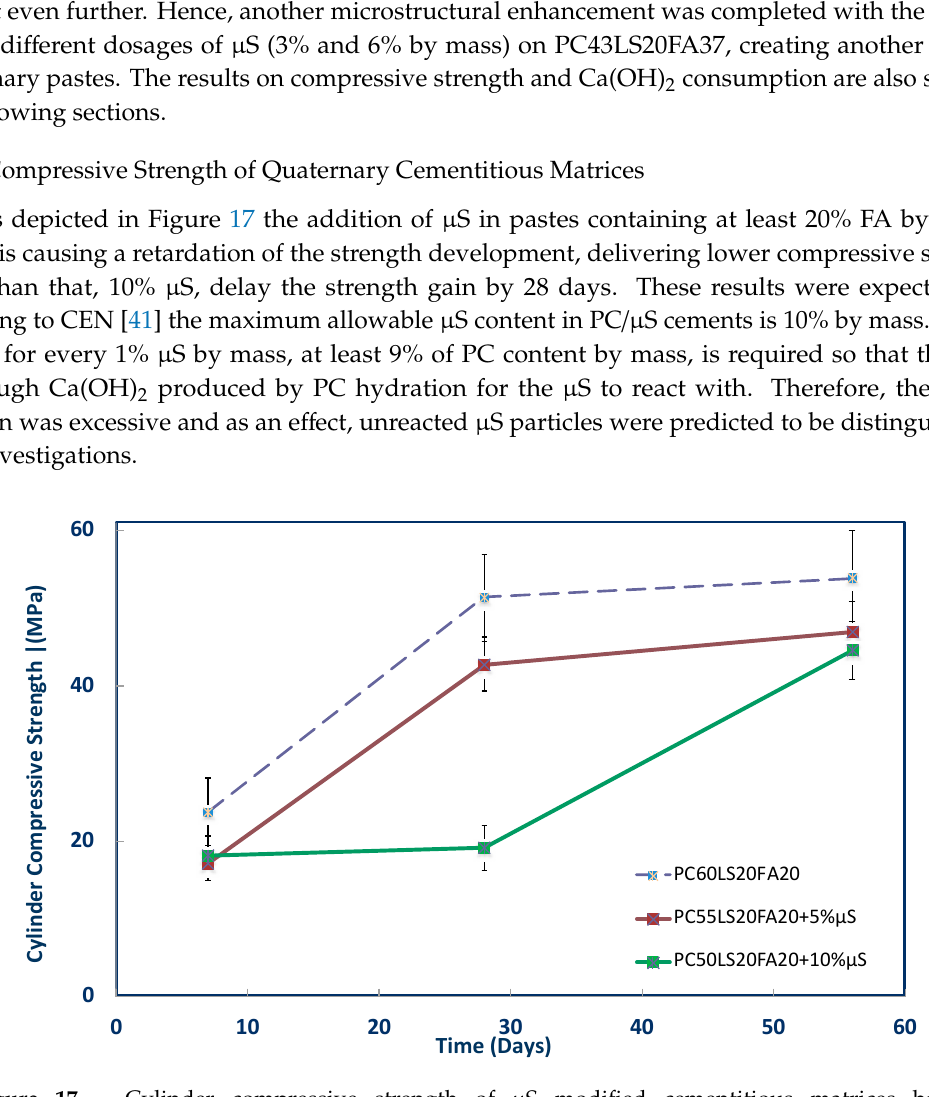
Figure 17. Cylinder compressive strength of µ S modified cementitious matrices based on PC60LS20FA20.